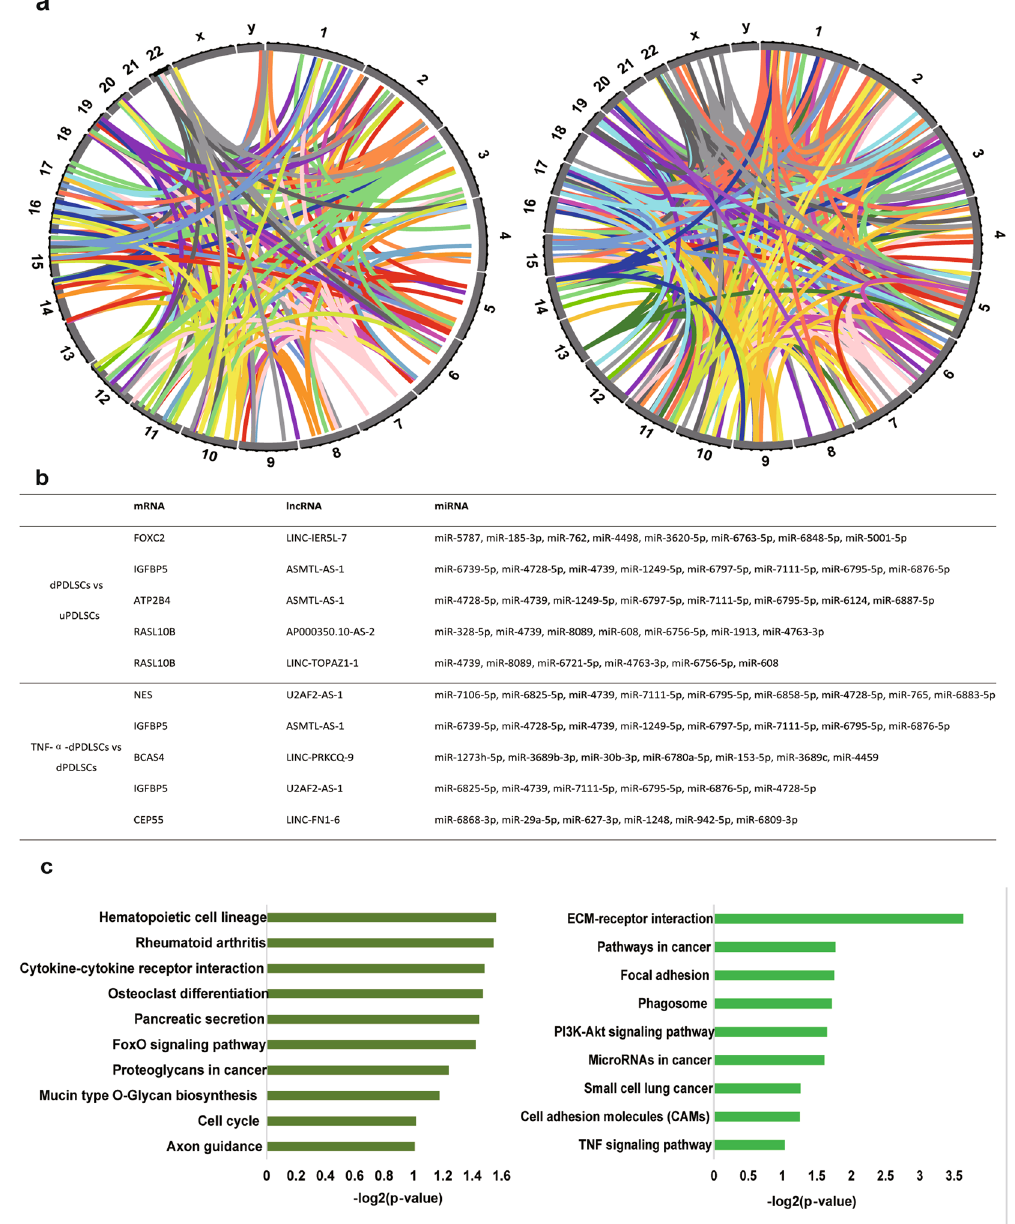
Figure 5. lncRNA-mRNA-related ceRNA network during osteogenic differentiation. ( a ) Circos plot showing mRNA-lncRNA ceRNA pairs for DE lncRNAs during PDLSC differentiation and TNF- α stimulation. ( b ) The top five mRNA-lncRNA ceRNA pairs and their shared miRNAs. ( c ) The significantly enriched pathways for mRNAs involved in ceRNA